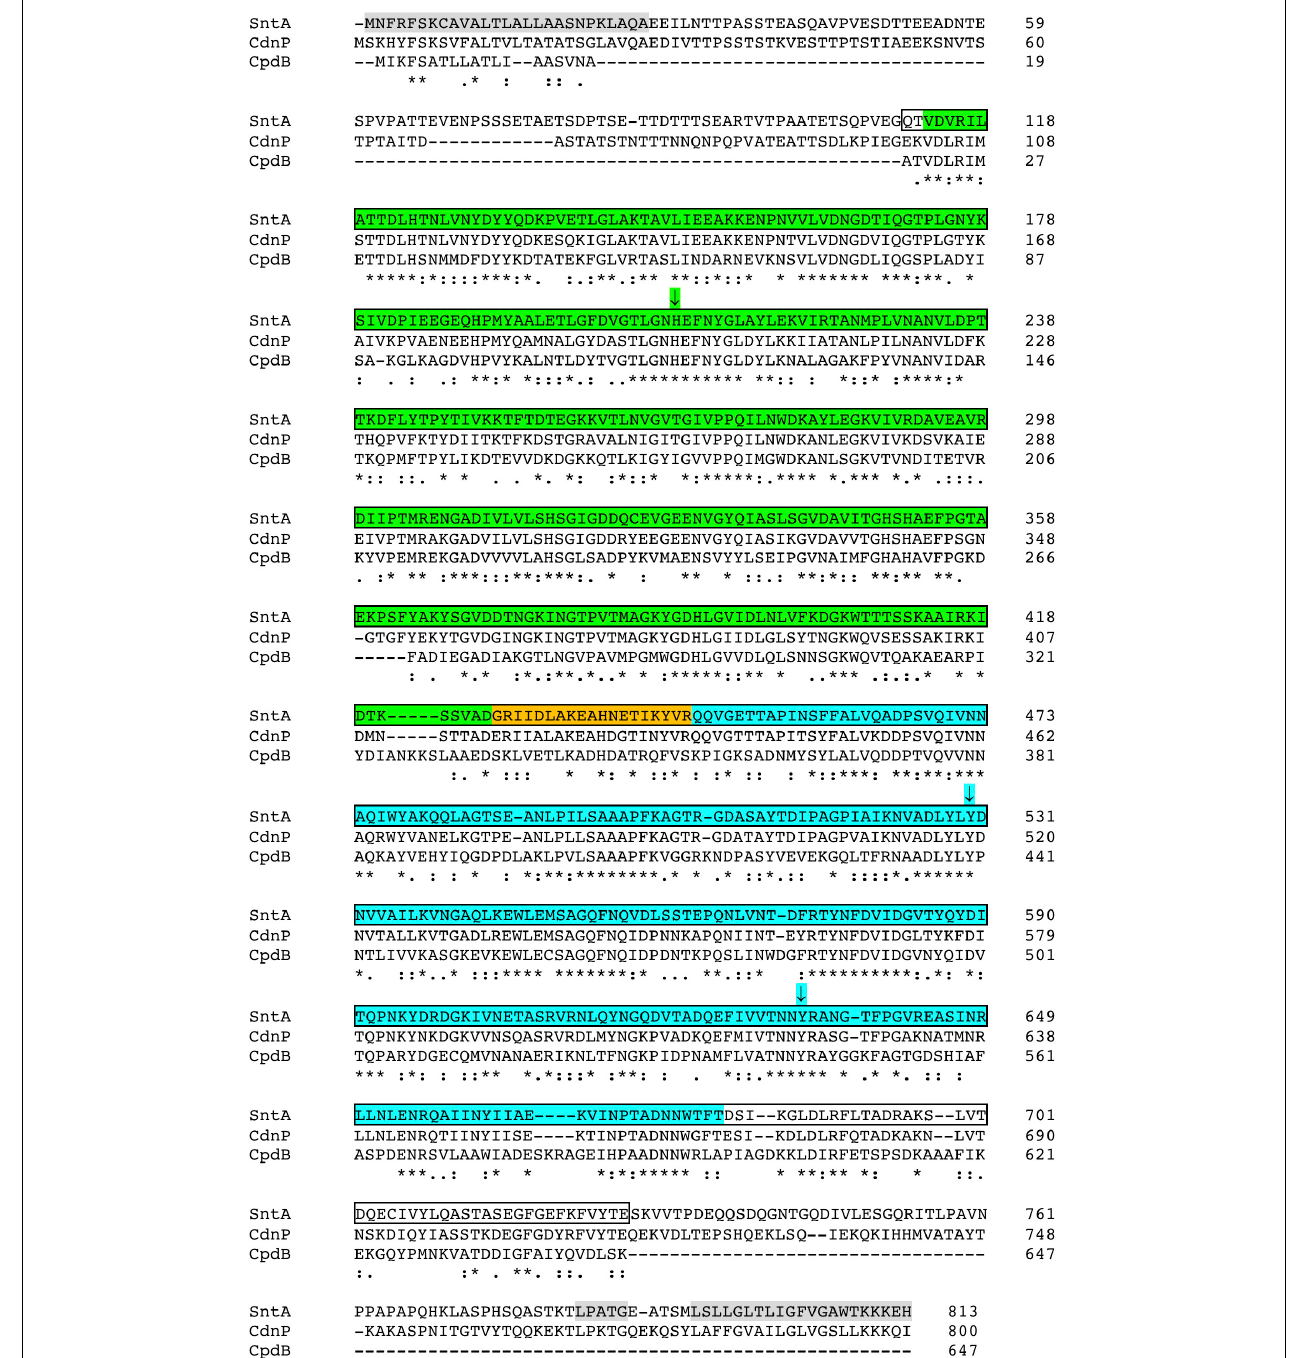
FIGURE 1 | Sequence alignment of streptococcal SntA and CdnP with Escherichia coli CpdB. Sequences correspond to full protein precursors taken from GenBank accessions AYV64543 (SntA; this work), WP_000033934 (CdnP) (Andrade et al., 2016), and WP_000589409 (CpdB) (López-Villamizar et al., 2016). Alignment was prepared with Clustal Omega online (https://www.ebi.ac.uk/Tools/msa/clustalo/; accessed January 15, 2022). The following elements are indicated, from N to C end, on SntA precursor sequence: signal peptide (gray; amino acids 1–27) as predicted by SignalP 6.0 (Teufel et al., 2022); metallophos domain (green; amino acids 113–426); interdomain linker (orange; amino acids 427–446); 5_nucleotid_C domain (cyan; amino acids 447–680); and C-terminal sorting signal (gray) comprising a LPXTG motif (amino acids 783–787) and a hydrophobic domain with a positively charged tail (amino acids 792–813). SntA core used to run substrate specificity and kinetics experiments corresponds to amino acids 111–727 (shown within borders), which align well with mature CpdB. According to NCBI Blast, SntA and CdnP display ≈ 60% identity and ≈ 74% similarity to each other over 99% of their sequences. Each of streptococcal proteins displays ≈ 45% identity and ≈ 63% similarity to CpdB over 97% of CpdB sequence. (*) Fully conserved residue; (:) strongly conserved residues; (.) weakly conserved residues. Capital letters are standard for amino acids.